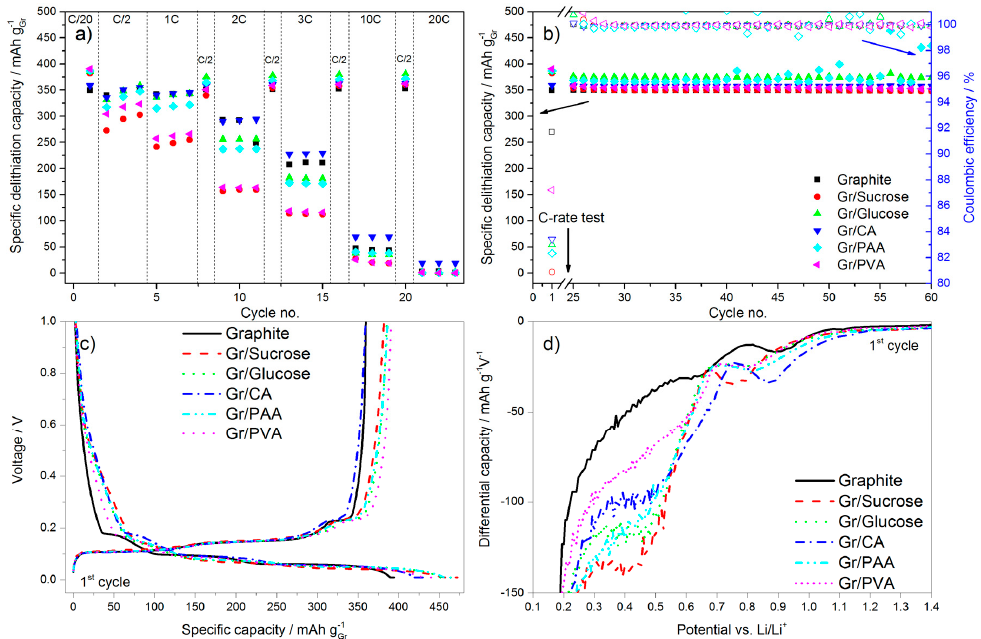
Figure 5. Electrochemical performance of pristine graphite and the carbon-coated graphite electrodes. ( a ) C-rate test; ( b ) constant cycling at C/2 (the arrows point at the corresponding y axes, closed symbols represent delithiation capacity, open symbols—coulombic efficiency); ( c ) first cycle voltage profile; and ( d ) enlarged portion of differential capacity plot of the first cycle.